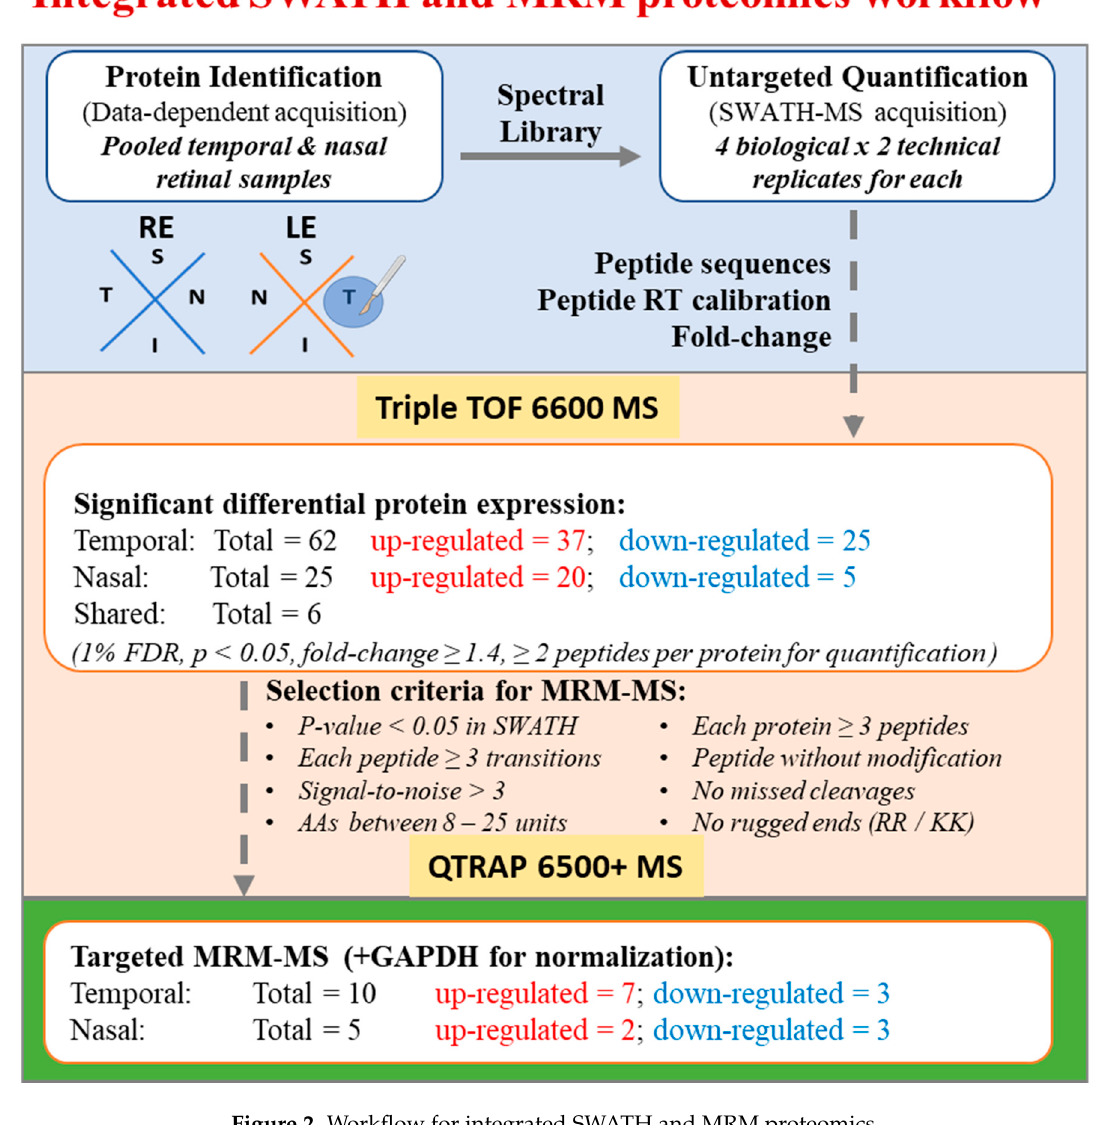
Figure 2. Workflow for integrated SWATH and MRM proteomics.